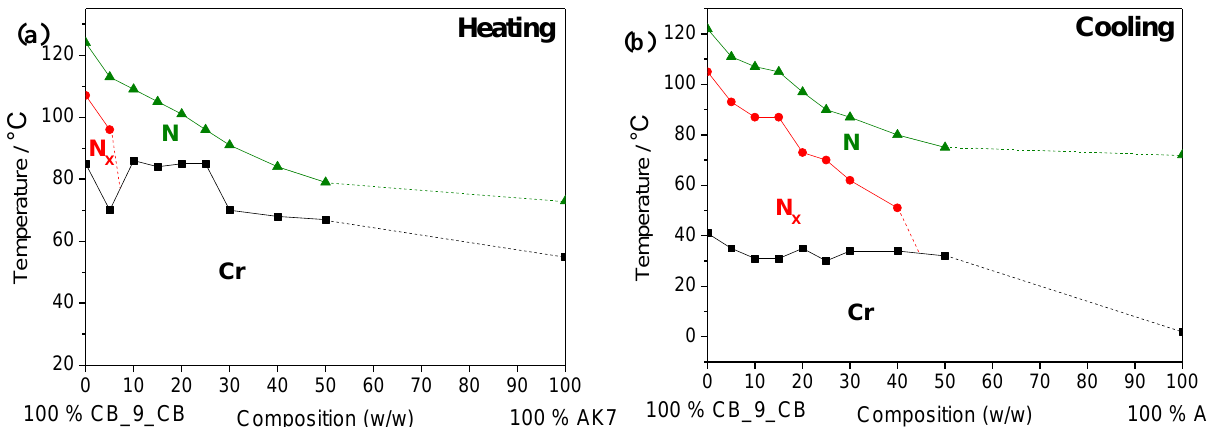
Figure 4. Transition temperatures of the binary mixtures of dimer CB_C9_CB in 1 , taken from the first DSC heating and cooling scans (10 K∙min −1 ); the phase diagram of the transition temperatures of these mixtures, taken from the first DSC ( a ) heating scans (10 K∙min −1 ) and ( b ) cooling scans (10 K∙min −1